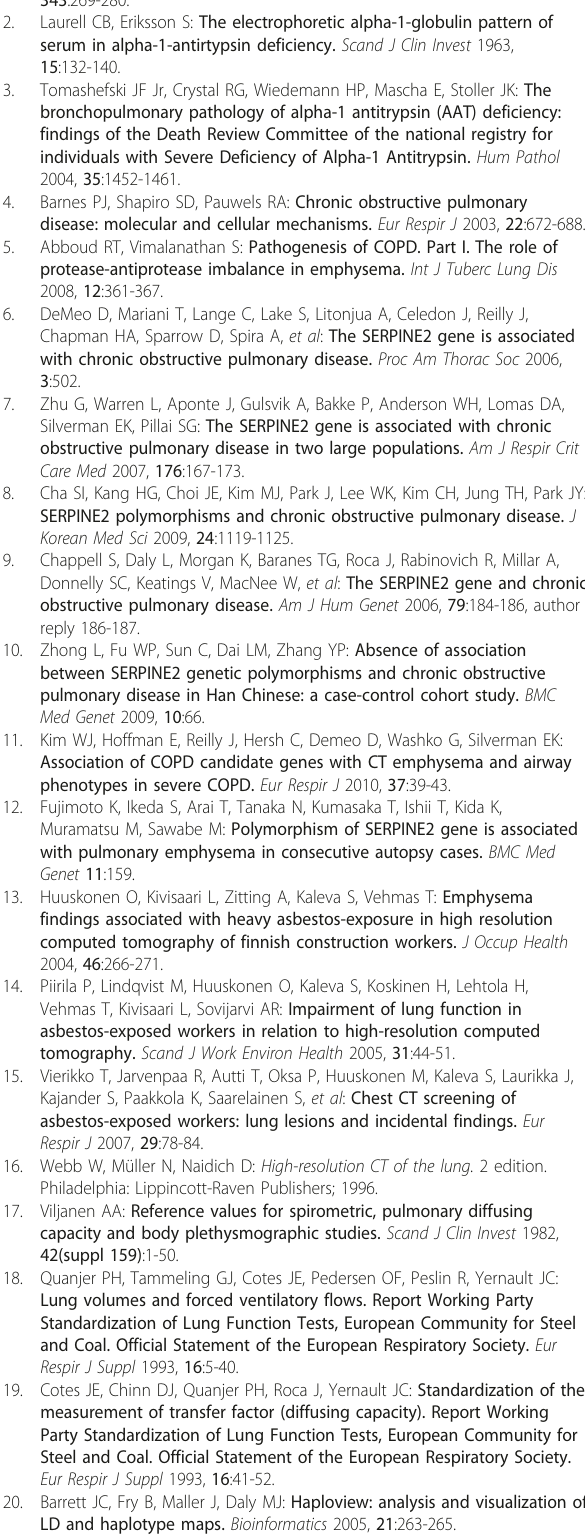
Additional file 1: Table S1 - Association between SERPINE2 polymorphisms, emphysema findings and pulmonary function separately in both case cohorts